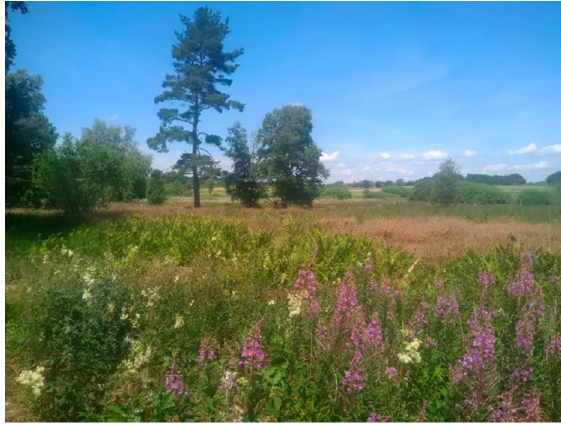
Figure 8. Schopflocher Moor on volcanic vent (Author 2020).